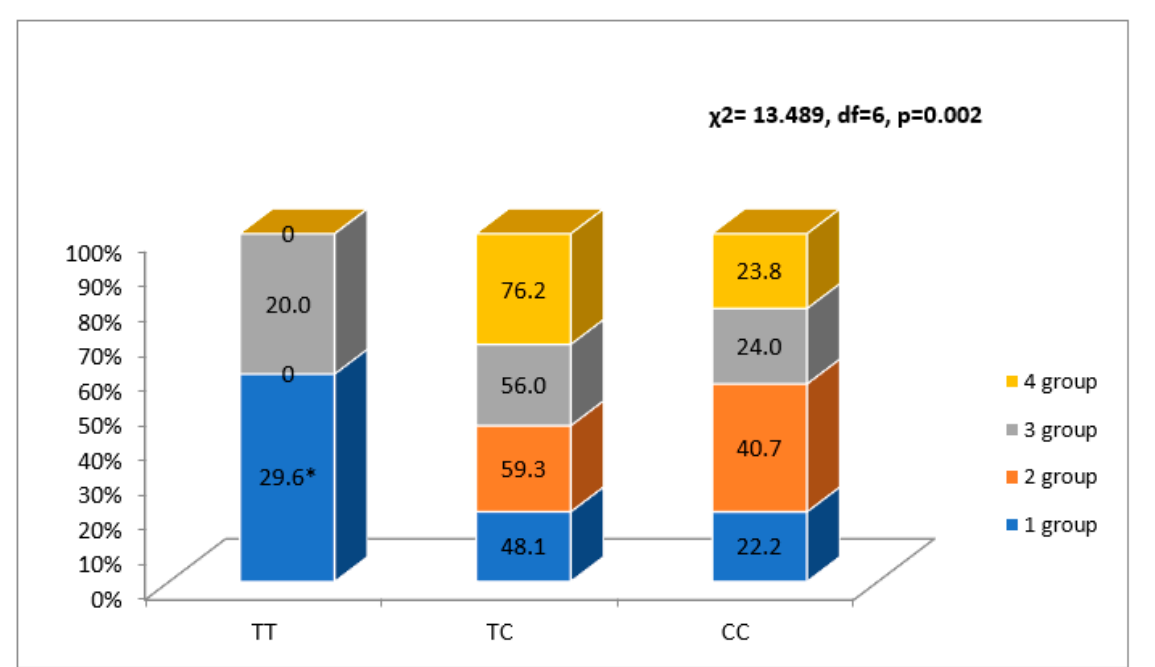
Figure 2. Association between NR3C2 gene polymorphism rs4635799 and FLVR after MI groups. * p < 0.05 as compared with group 2.